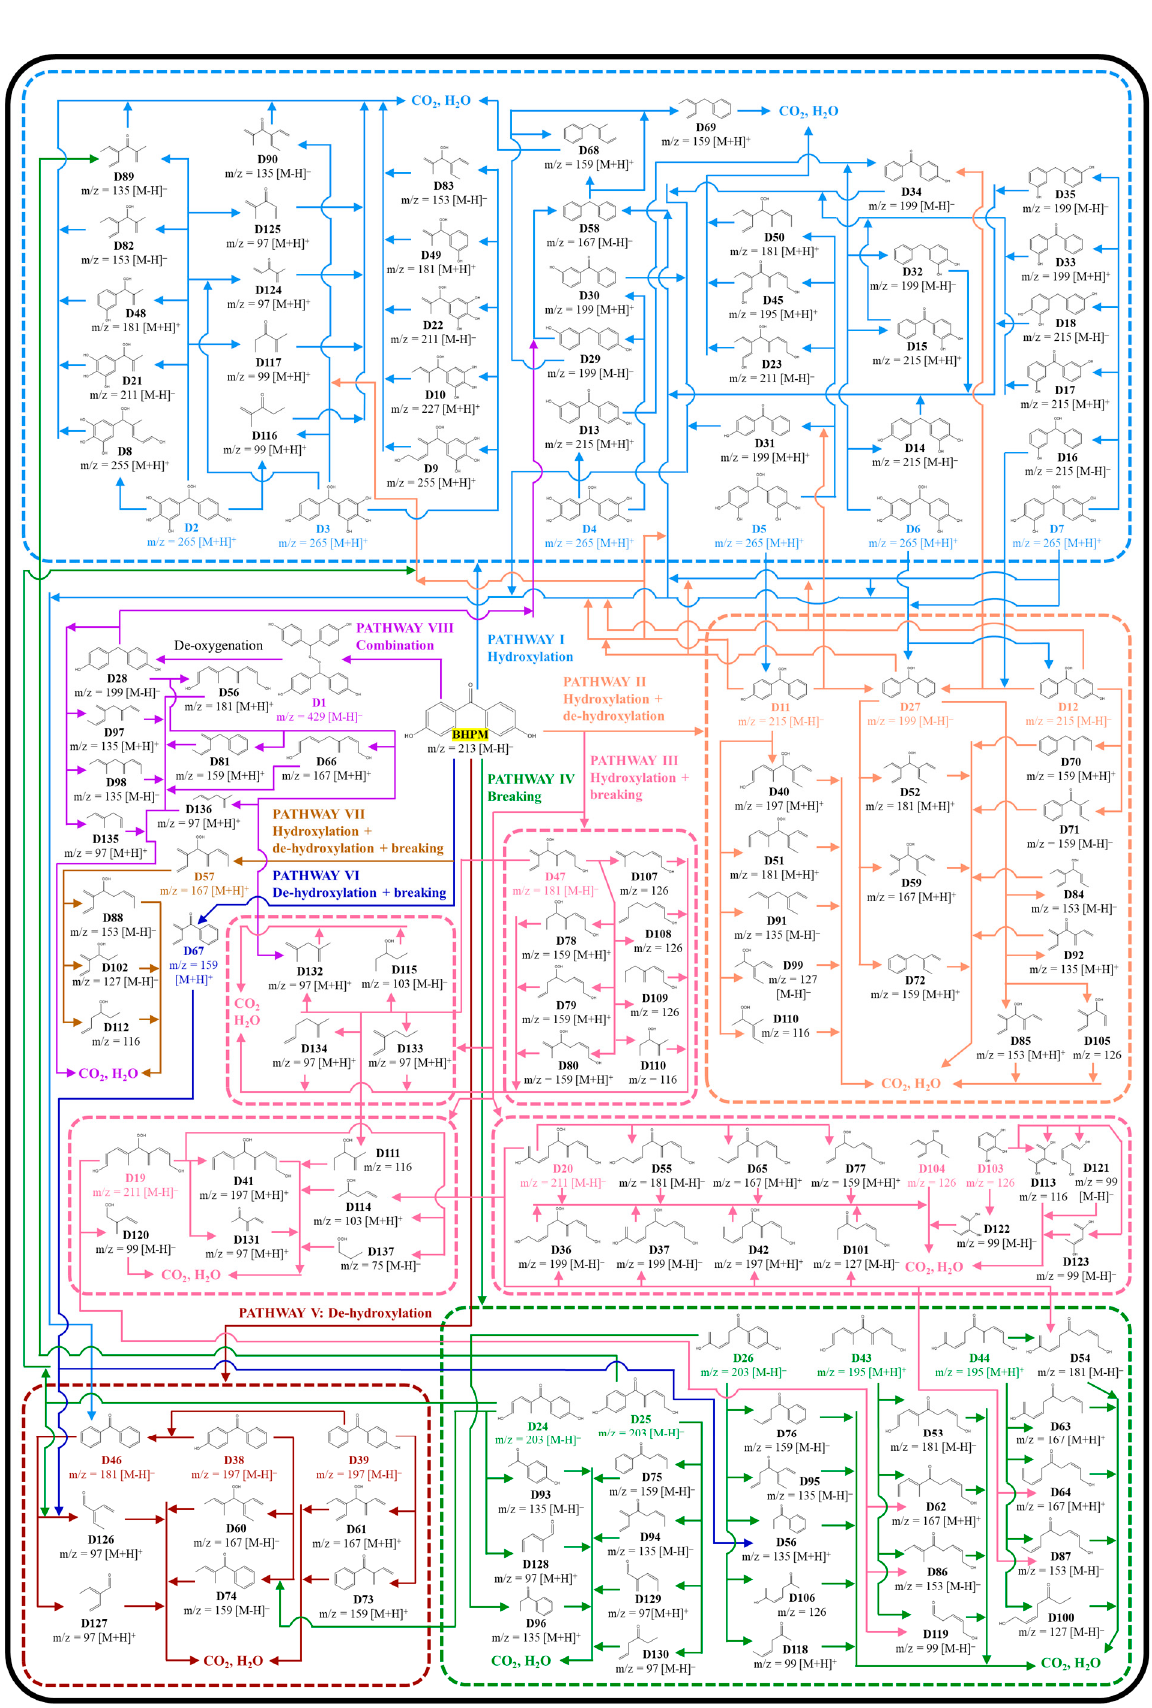
Figure 11. A proposed degradation pathway of BHPM by CTO-activated oxone.